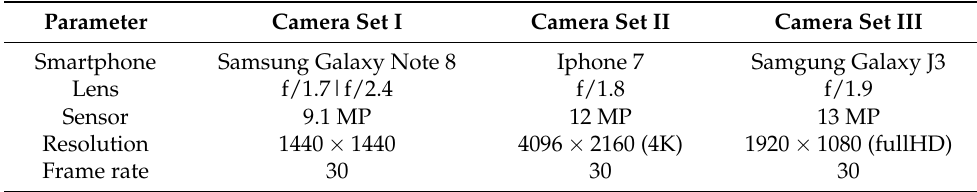
Table 1. The parameters of the acquisition equipment used for the collection of the WrightBroS